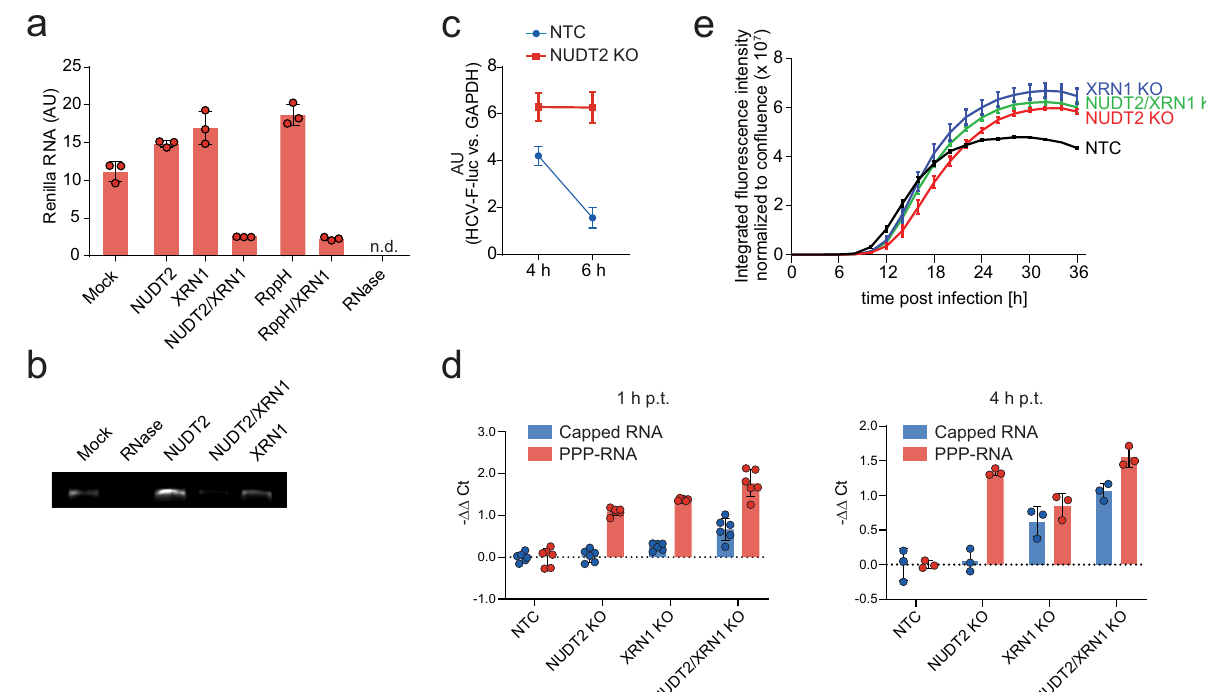
Fig. 5 NUDT2 is preparing RNA to serve as XRN1 substrate. a In vitro transcribed PPP-renilla RNA was left untreated (mock) or incubated with 600 nM NUDT2, 1 U XRN1, 600nM NUDT2 together with 1 U XRN1, 5 U RppH, or 5 U RppH together with 1 U XRN1 and 10 U RNase for 4 h. The remaining RNA was quanti fi ed by RT-qPCR. The bar plot shows the fold change compared to input RNA as the mean ± SD of three technical replicates. b In vitro synthesized HCV RNA was treated with 5 U RNase, 600 nM NUDT2, 1 U XRN1, or co-treated with 600 nM NUDT2 and 1 U XRN1 and then analyzed on an agarose gel. c In vitro transcribed HCV RNA encoding luciferase was electroporated into HeLa CRISPR KO cells lacking NUDT2 or HeLa cells treated with a non-targeting-control vector (NTC). Viral RNA load was quanti fi ed 4 and 6 h post electroporation by the abundance of fi re fl y luciferase RNA. d In vitro transcribed triphosphorylated renilla RNA and capped fi re fl y luciferase RNA were co-electroporated into Hep3B CRISPR/Cas9 KO cells lacking NUDT2 , XRN1 , or both NUDT2 and XRN1 , or Hep3B cells treated with a non-targeting-control vector (NTC). RNA load was quanti fi ed 1 and 4 h post electroporation by quantifying the abundance of fi re fl y luciferase or renilla RNA. e Hep3B treated with CRISPR/Cas9 lentivectors targeting NUDT2 , XRN1 , NUDT2 , and XRN1 or with a non-targeting-control vector (NTC) were infected with VSV-GFP at MOI 0.01. GFP expression was monitored using automated live-cell microscopy. The data points are displayed as the mean of fi ve technical replicates ± SD. Shown is one representative experiment of three independent